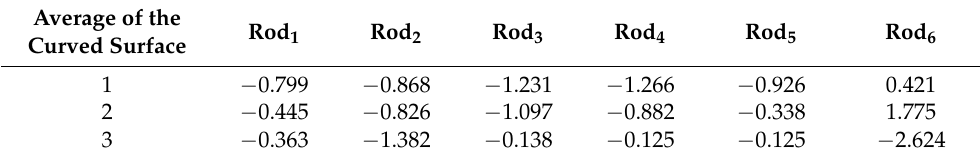
Table 3. Errors in the position of the support points (unit: mm). Average of the